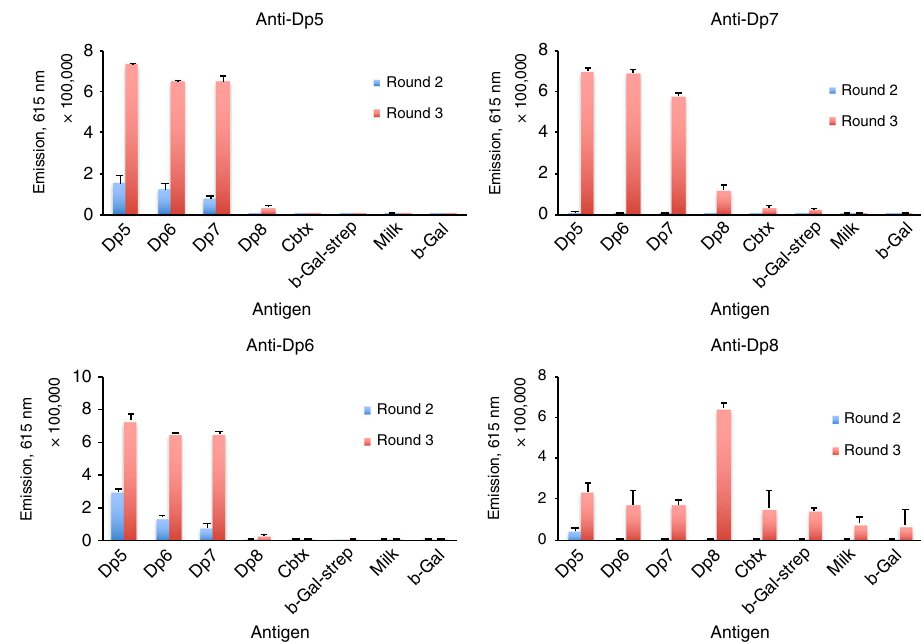
Fig. 1 Polyclonal phage ELISA signals for the output phages for each selection. A signi fi cant increase in binding signal is observed from round 2 to 3 for all selections, and for selections against Dp5, Dp6, and Dp7, a high degree of cross-reactive binding exists for the phages against all three antigens (Dp5, Dp6, and Dp7). Negative control antigens: Cbtx α -cobratoxin, b-Gal β -galactosidase, Strep Streptavidin. All experiments were performed in triplicates on distinct samples. Error bars represent standard